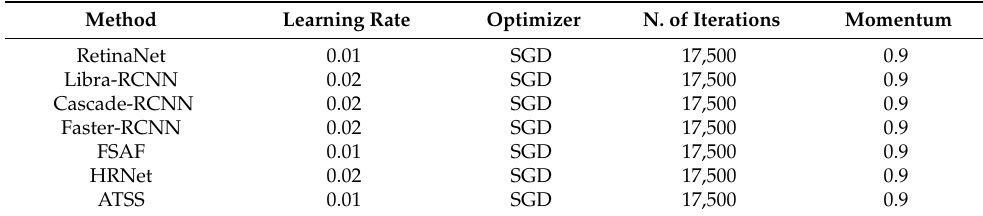
Table 3. Hyper-parameters of each object detection